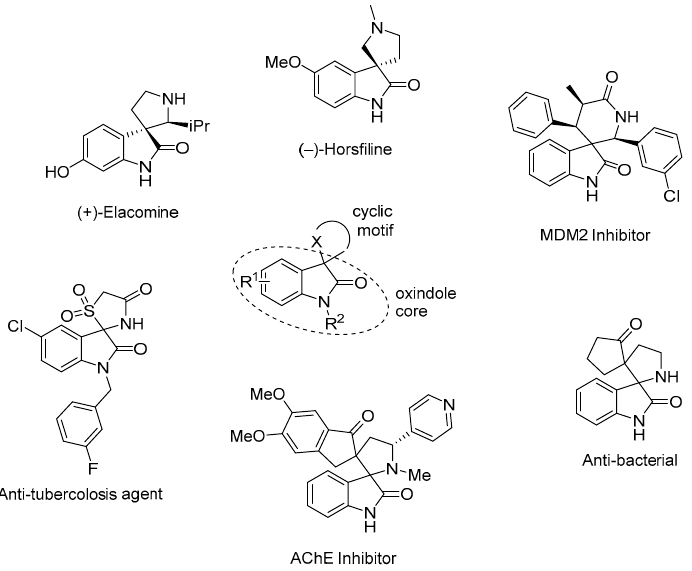
Figure 1. Examples of bioactive compounds built around the oxindole framework.